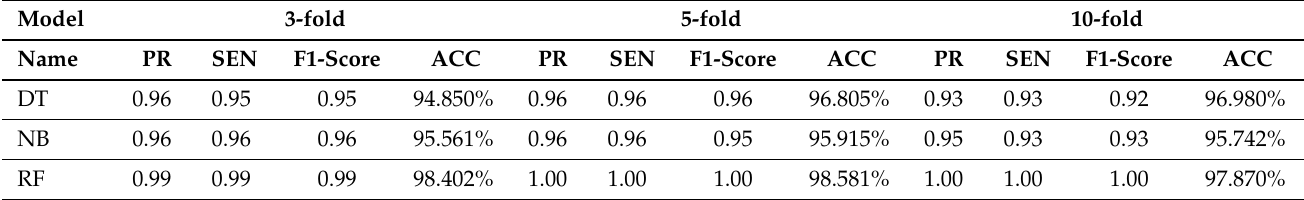
Table 9. Performance of ML models in experiment-4 (Cross-validation + No FS